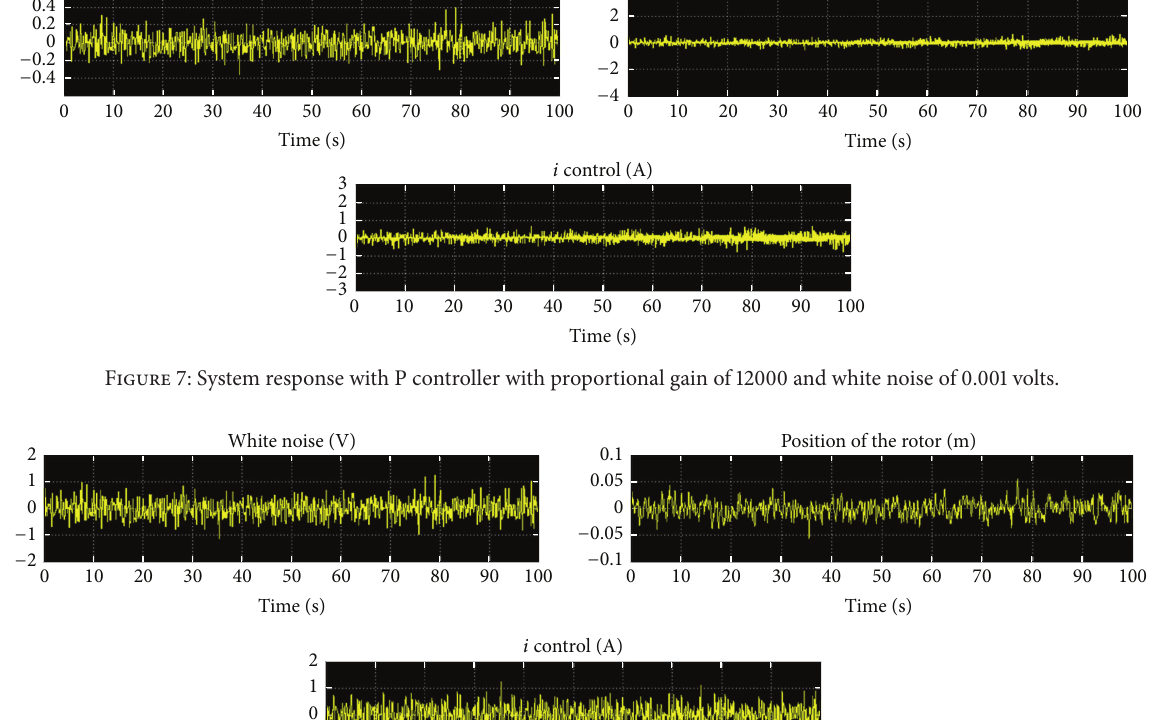
has been tested using experimental noise data [7]. This data consists of recorded noise in a range of 0.0048 volts. The PID parameters were found for the proportional gain to be 319.0187, for the integral gain to be 1273.2977, and for the differential gain to be 7.2565. Several values have been tested for the gains and corresponding curves of reference